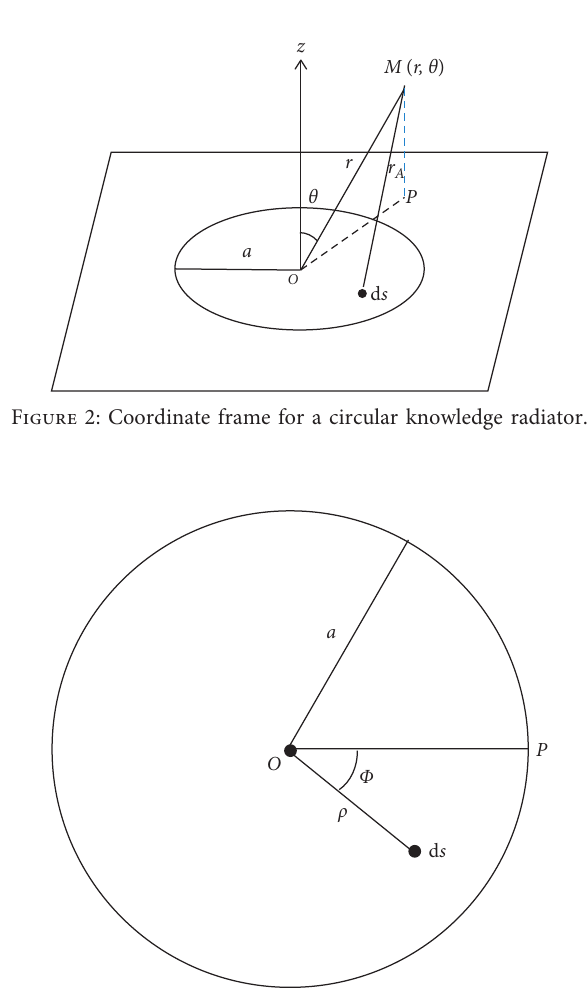
Figure 3: Polar coordinate frame on the circular knowledge radiator.